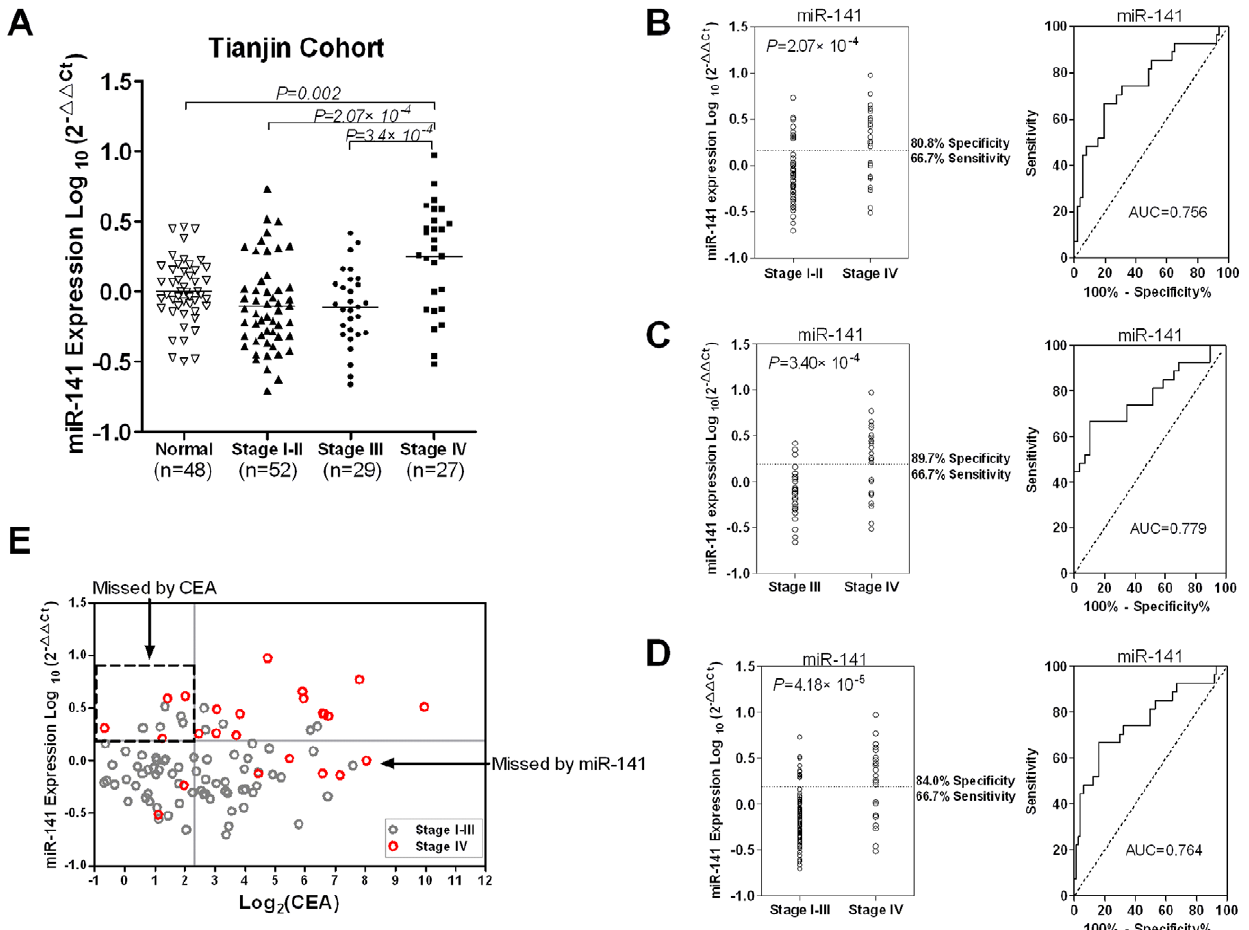
Figure 4. Higher plasma miR-141 level is associated with Stage IV colon cancer patients in the validation data set. Small RNA isolation and miR-141 quantitative RT-PCR assays were performed in the same way as for the training cohort. (A) The Wilcoxon two-sample test was performed to compare miR-141 levels between normal controls and/or colon cancer patients with different clinical stages. (B–D) The same analyses were performed to compare miR-141 levels between Stage IV cases and Stage I–II cases (B), between Stage IV and Stage III cases (C), and between Stage IV and Stage I–III cases (D), respectively. ROC analysis was performed to determine the sensitivity and specificity with the value of AUC in the right panel. (E) Combination of CEA and miR-141 identified additional metastatic patients that were missed by either marker alone. See Figure 3 for the definition of the cut-off values for CEA and miR-141.